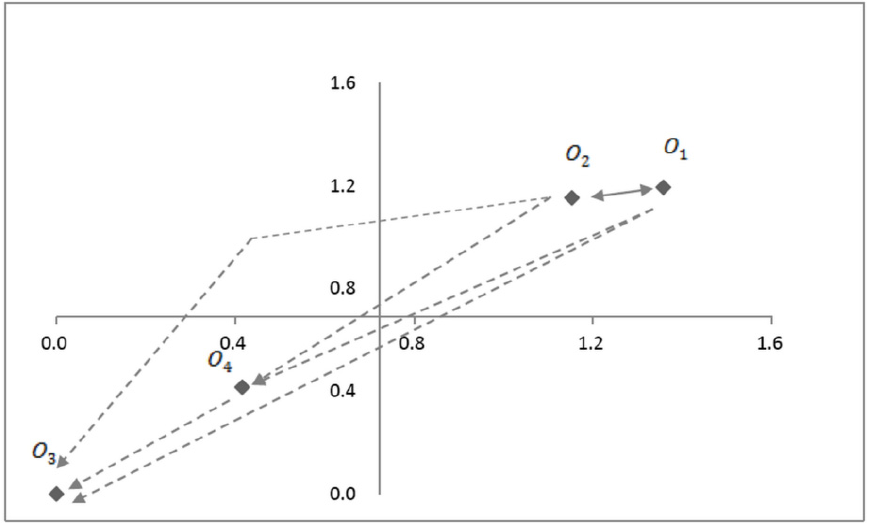
Figure 1. Casual Diagram for